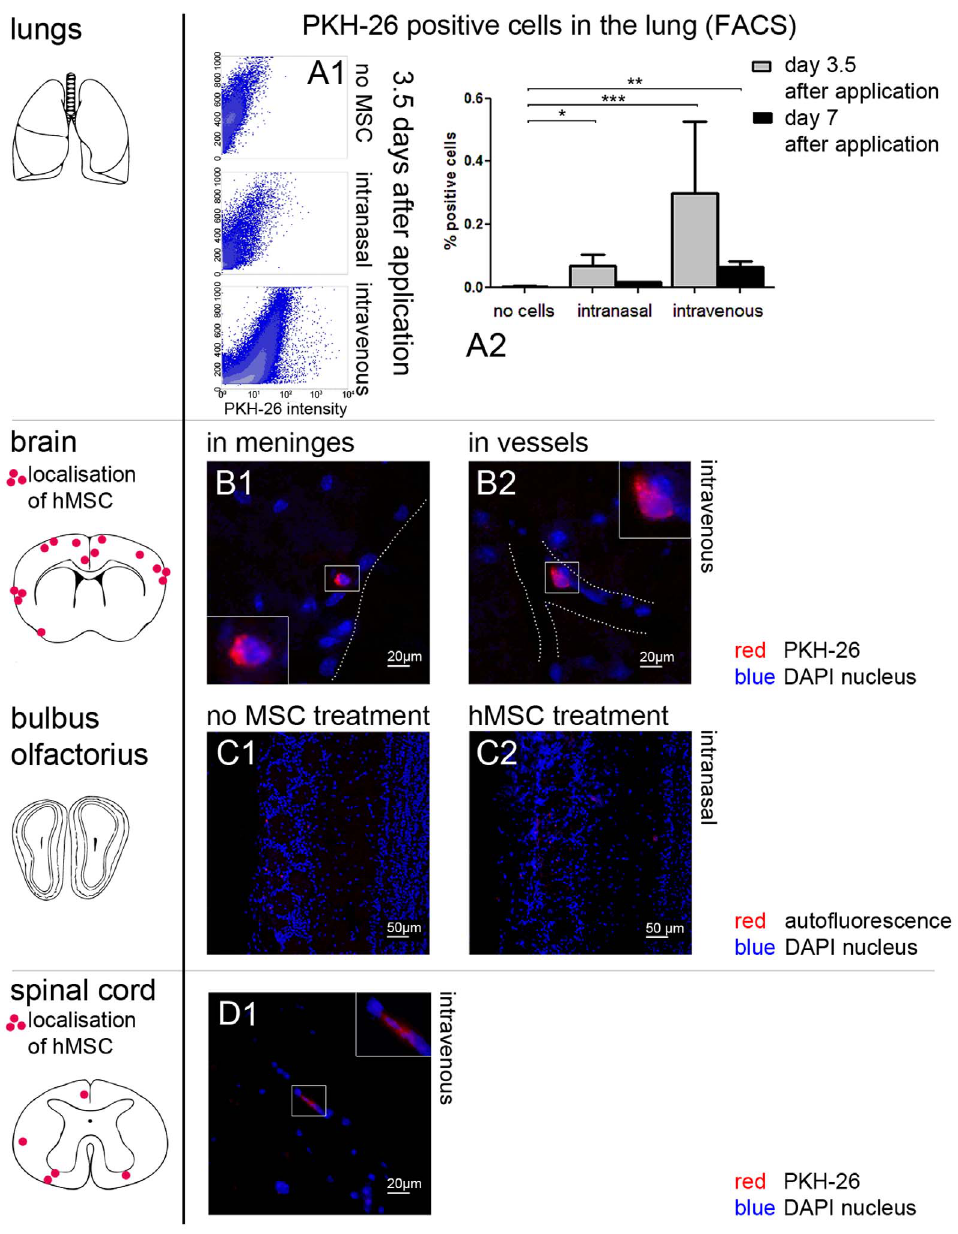
Figure 2. Cell tracking of human MSC with PKH-26. ( A1–A2 ) After application of human MSC red fluorescent cells were found in the lungs of treated animals in the FACS analysis. (A2) Each bar represents the mean 6 SEM. Significant differences between untreated and human MSC treated groups are indicated by asterisks (* P , 0.05, ** P , 0.01, *** P , 0.001). ( B1–B2 ) The distribution of PKH-26 positive cells after i.v. injection of human MSC shows a hematogenic pattern in the brain. Human MSC (red) can be in or near the meninges (B1, here exemplarily day 7 after application) or seem to be attached to vessel walls (B2, here exemplarily day 3.5 after application). ( C1–C2 ) In the bulbus olfactorius no red fluorescent cells were found in animals without cell treatment (C1) or after i.n. application of human MSC (C2). Here day 3.5 after application is shown exemplarily. Only some dim autofluorescence can be seen (red). ( D1 ) PKH-26 positive cells (red) were found in very low numbers in the spinal cord after i.v. injection of human MSC (here exemplarily day 3.5 after application). For better visibility borders of parenchyma are illustrated with a dotted line (B1, B2). Nuclei were counterstained with DAPI (blue) (B1-D1).